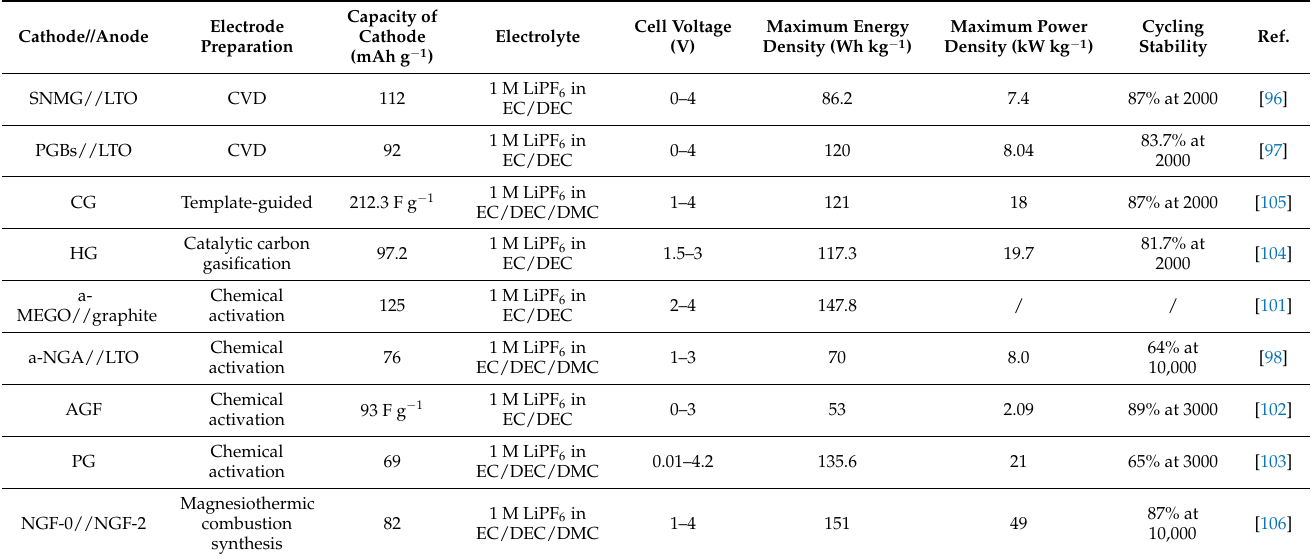
Table 3. Properties of pure graphene-based cathode and the performances of LICs based on